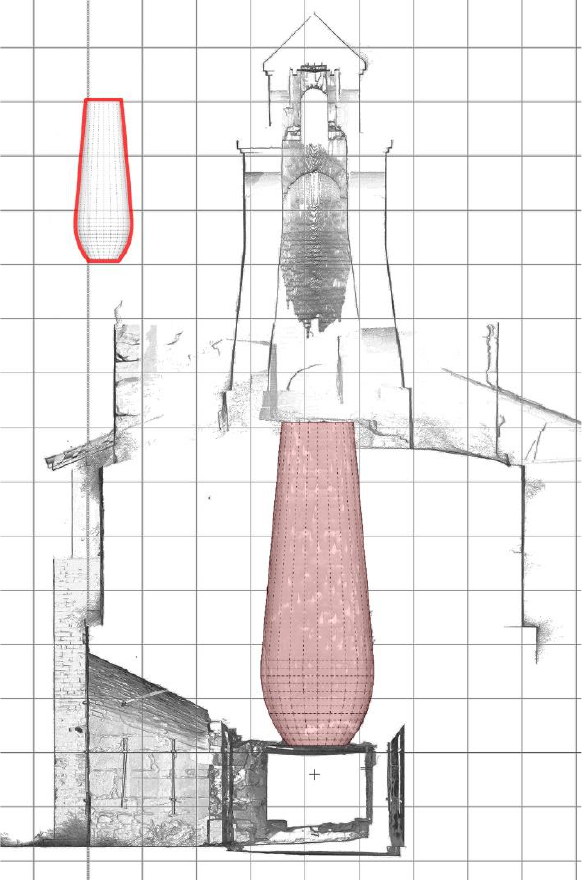
Figure 9: the south oven of Ipanema analysed by three- dimensional tools (point cloud database and 3D model) with identification of inner void silhouette on 1mx1m grid (digital elaboration by the